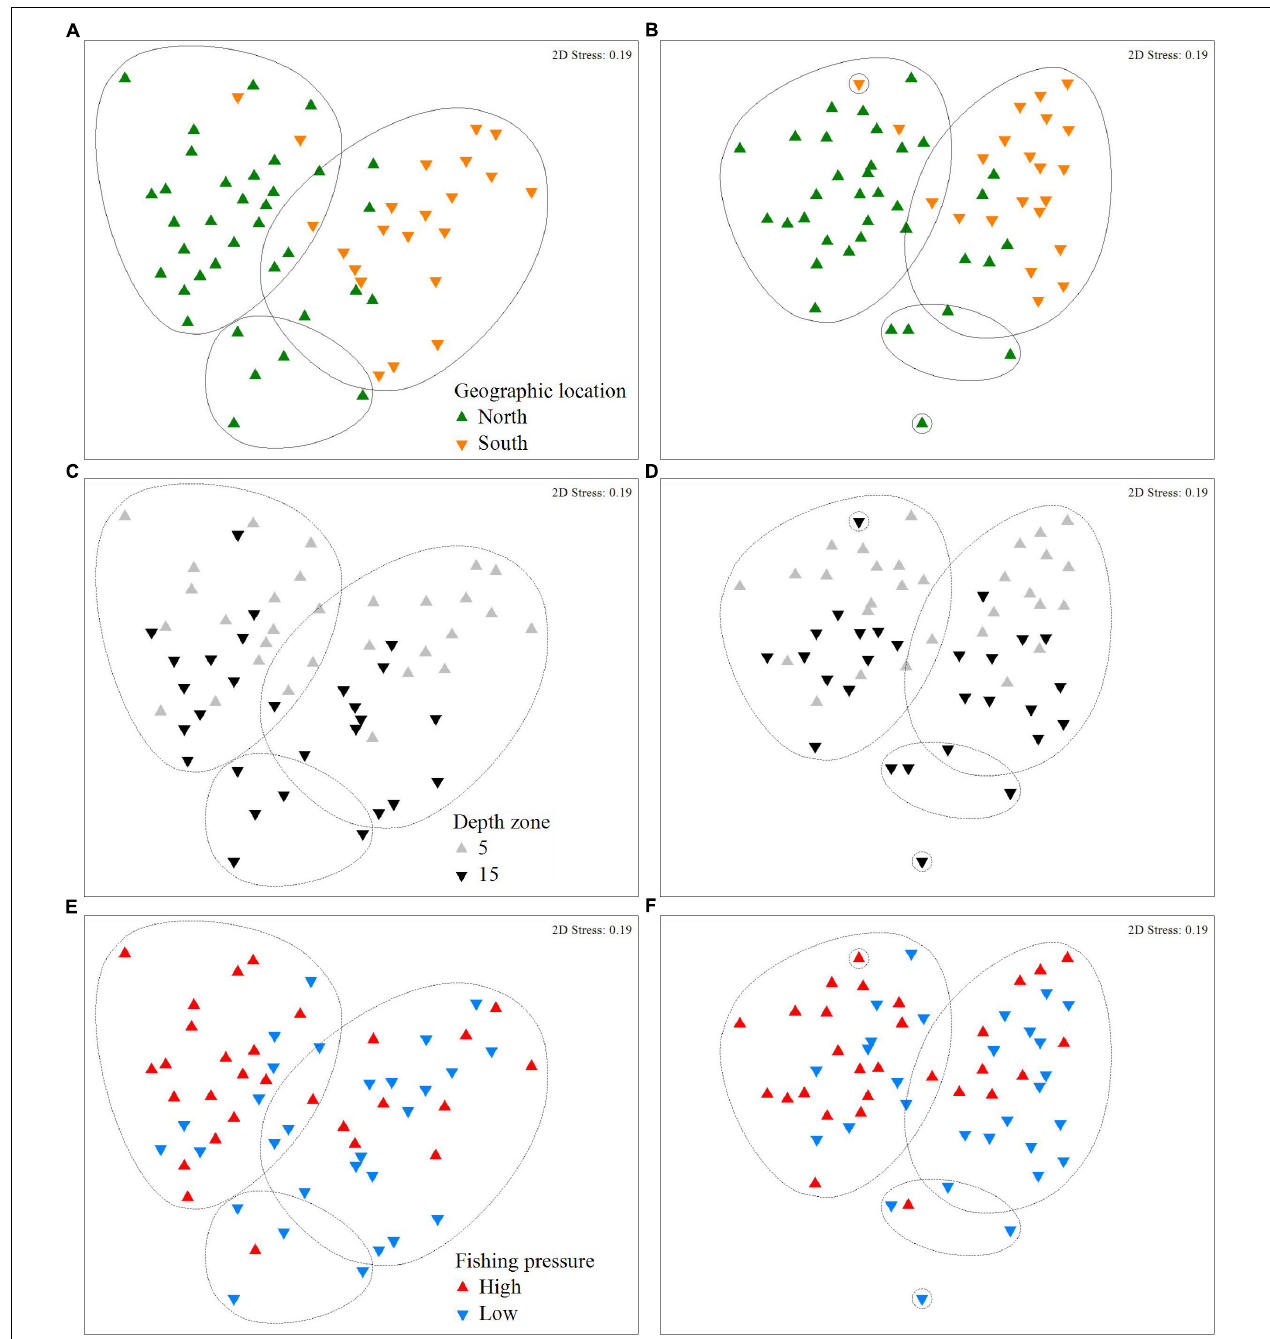
FIGURE 5 | Non-metric Multidimensional Scaling (nMDS) plot of fish density (A,C,E) and biomass (B,D,F) , in relation to sites located in different geographic locations (north or south Aegean Sea), depth zones (5 and 15 m), and which are subjected to different levels of fishing pressure (high or low). Points represent different depth stations (i.e., 28 stations, as in two stations only data from the 5 m depth zone were considered; for details see description in section “Materials and Methods”). Clusters represent 50% similarity; continuous line indicates the most discrete clustering.